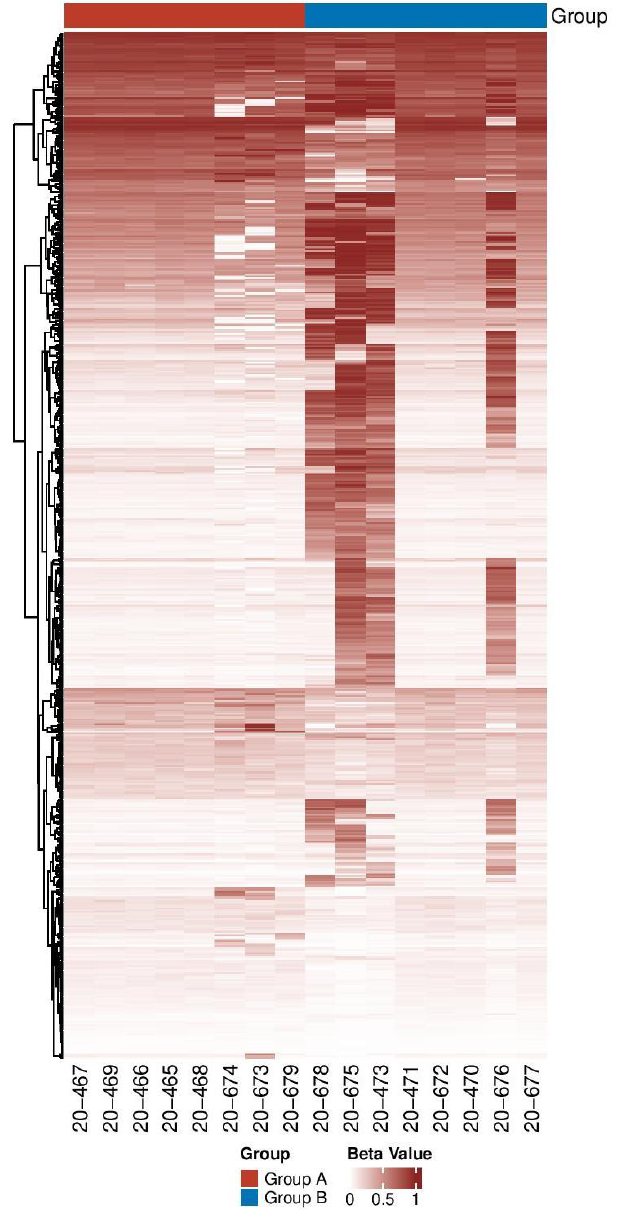
Figure 1. Heat map showing both Groups A (TD) and B (FXS-like symptoms) methylation patterns. As the color gets darker, this means more hypermethylation. The heatmap is showing the β values from 570 significant CpGs. CpGs were hierarchically clustered.